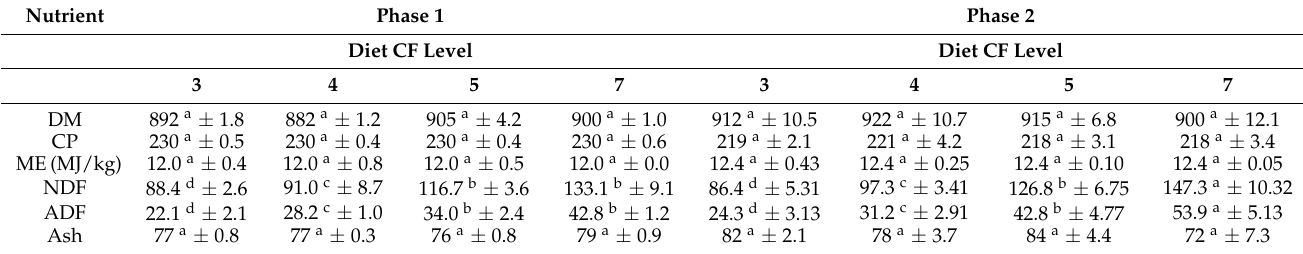
Table 2. Nutrient composition (g/kg) (mean ± standard error, on DM basis) of the experimental diets fed to the male Ross 308 broiler and Venda chickens during Phases 1 and